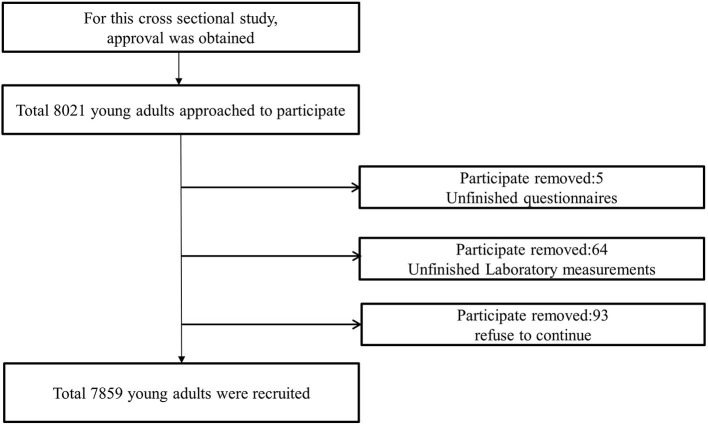
Flow chart of sample inclusion and exclusion.